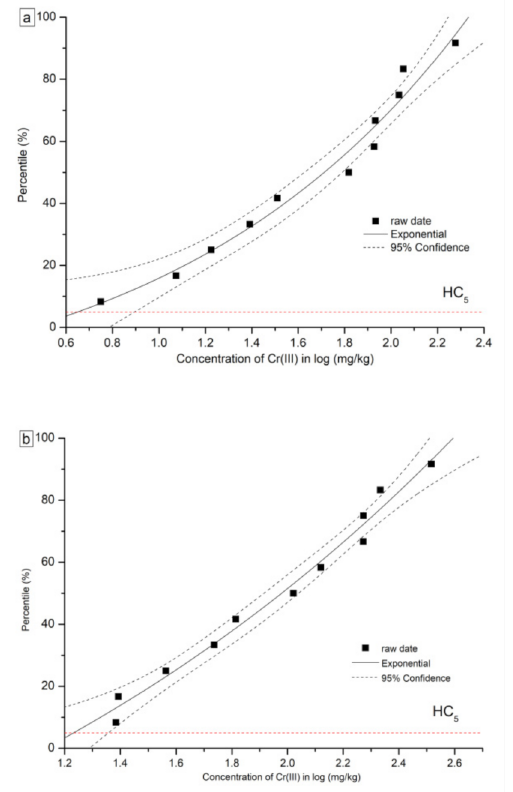
Figure 4. Curves of species sensitivity distribution for Cr (III) based on ( a ) EC 10 , ( b ) EC 20